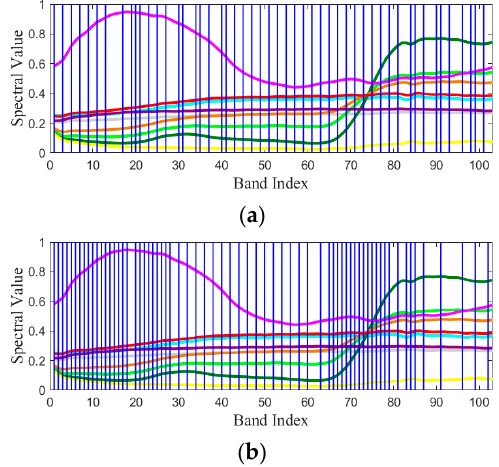
Figure 10. The BG results for the Pavia experiment. ( a ) FNG; ( b ) BD.